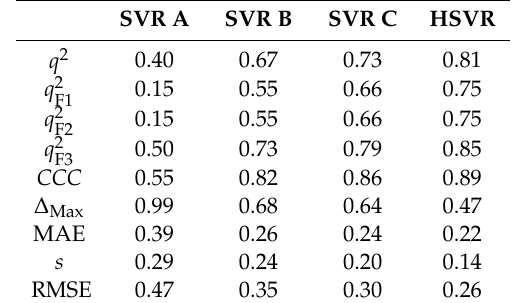
Table 3. Statistic evaluations, correlation coe ffi cients q 2 , q 2 coe ffi cient ( CCC ), maximal absolute residual ( ∆ Max ), mean absolute error (MAE), standard deviation ( s ), and RMSE evaluated by SVR A, SVR B, SVR C, and HSVR in the test set.